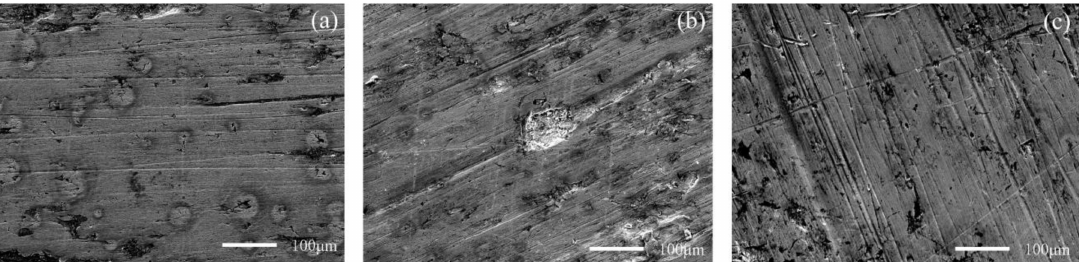
Figure 10. SEM morphology of worn surfaces of ZM4-13 with varying percentage of coal gangue at